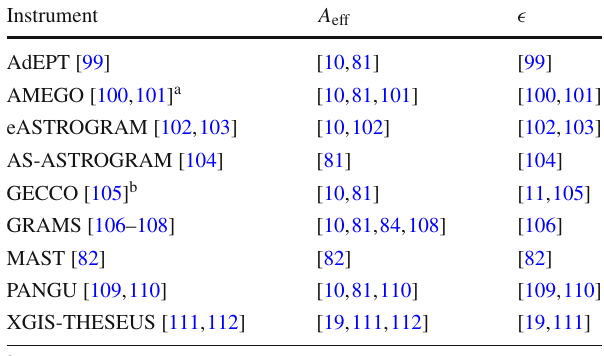
Table 5 Prospective constraints classification. MeV panel: AdEPT, AMEGO,eASTROGRAM,GECCO,GRAMS,MASTPANGU(alpha- betical order), taken separately. “+ EXGB” indicates that the target mentioned has been considered on top of the EXGB